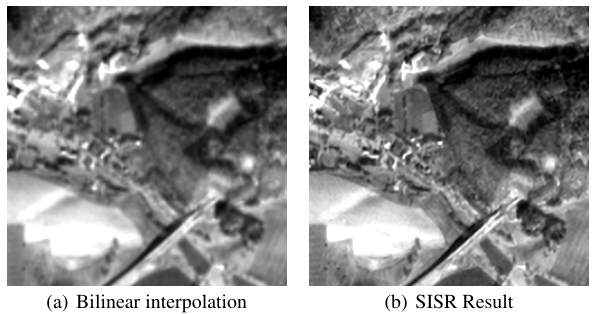
Figure 9. Enhancement of band 4 (red) with a native GSD of 10 m (left) to 5 m